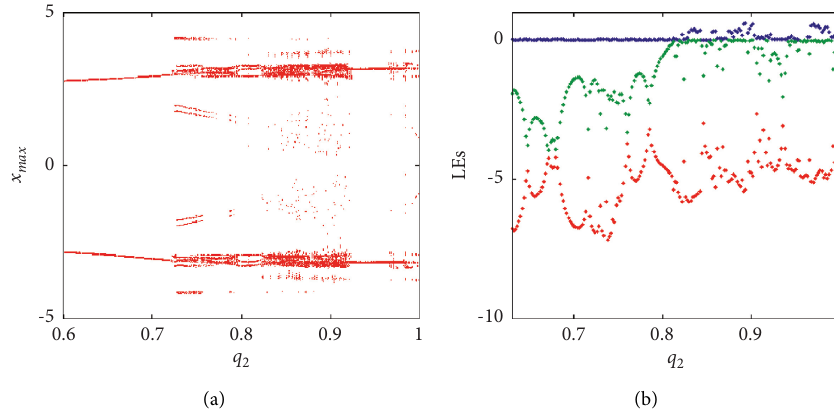
Figure 4: (a) The diagram of bifurcation. (b) Lyapunov exponents of system (4) when q parameters a � 1 and b � − 9 and the IC ( x